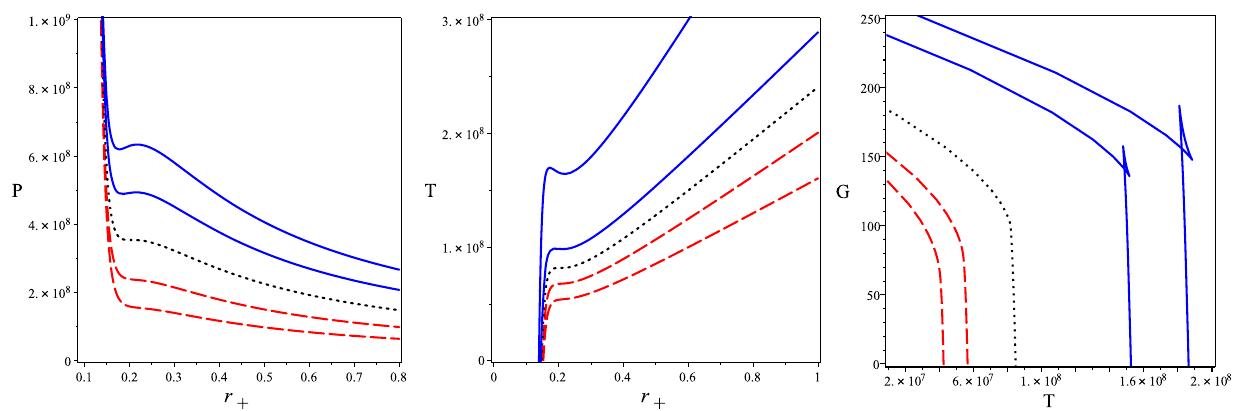
Fig. 23 Hyperbolic black hole in Lovelock gravity: P − r + (left), T − r + (middle) and G − T (right) diagrams; we have set k = − 1, d = 8, q = 1, and α = 0 . 01. Left panel: T < T c (dashed lines),